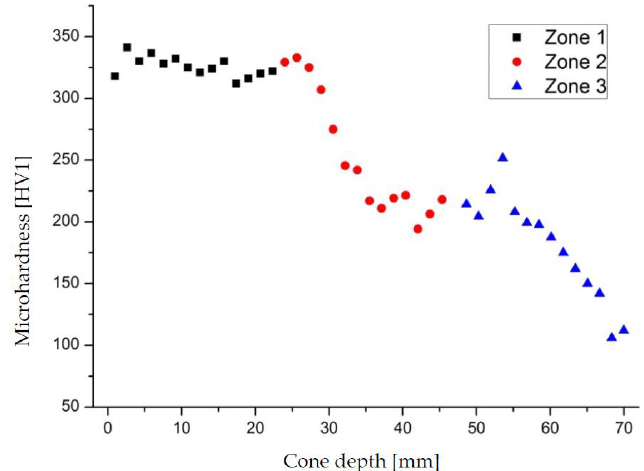
Figure 8. Microhardness vs. cone depth for the three zones in the Figure 7b.